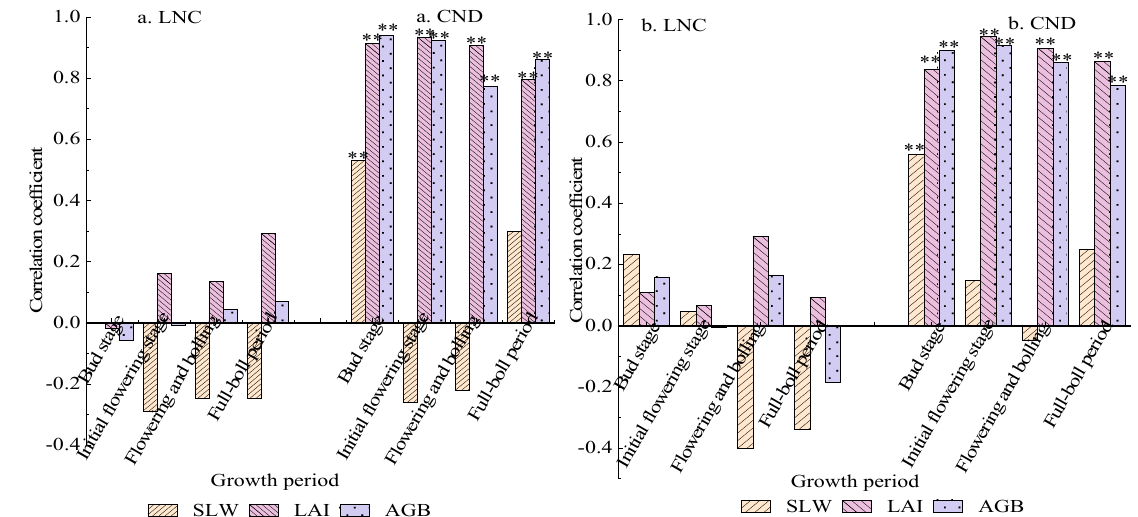
Figure 4. Correlations between nitrogen and AGB, LAI, and SLW at different growth stages of cotton in 2019 (( a ): Xinluzao 45, ( b ): Xinluzao 53) (** indicates that significant difference is achieved under p < 0.01).